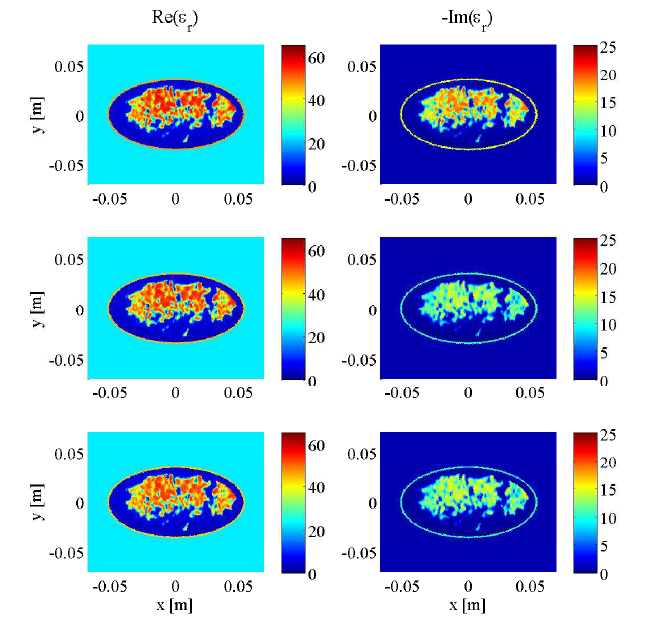
Figure 5. Complex dielectric properties of University of Wisconsin 2D synthetic breast model at 1.0 GHz ( top ), 2.0 GHz ( middle ) and 3.0 GHz ( bottom